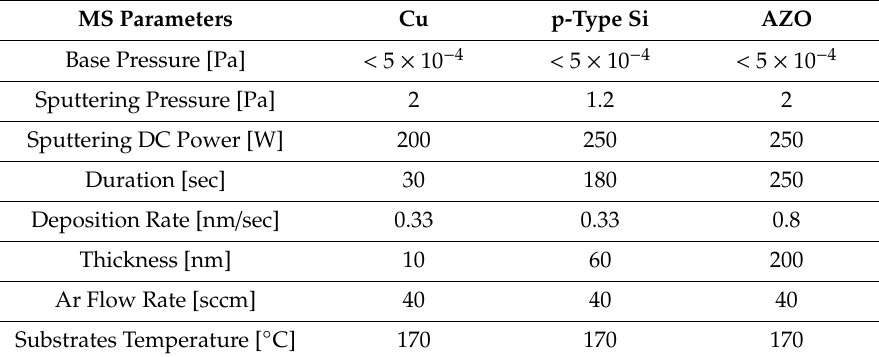
Table 1. Parameters of Deposition of Cu and Si by Magnetron